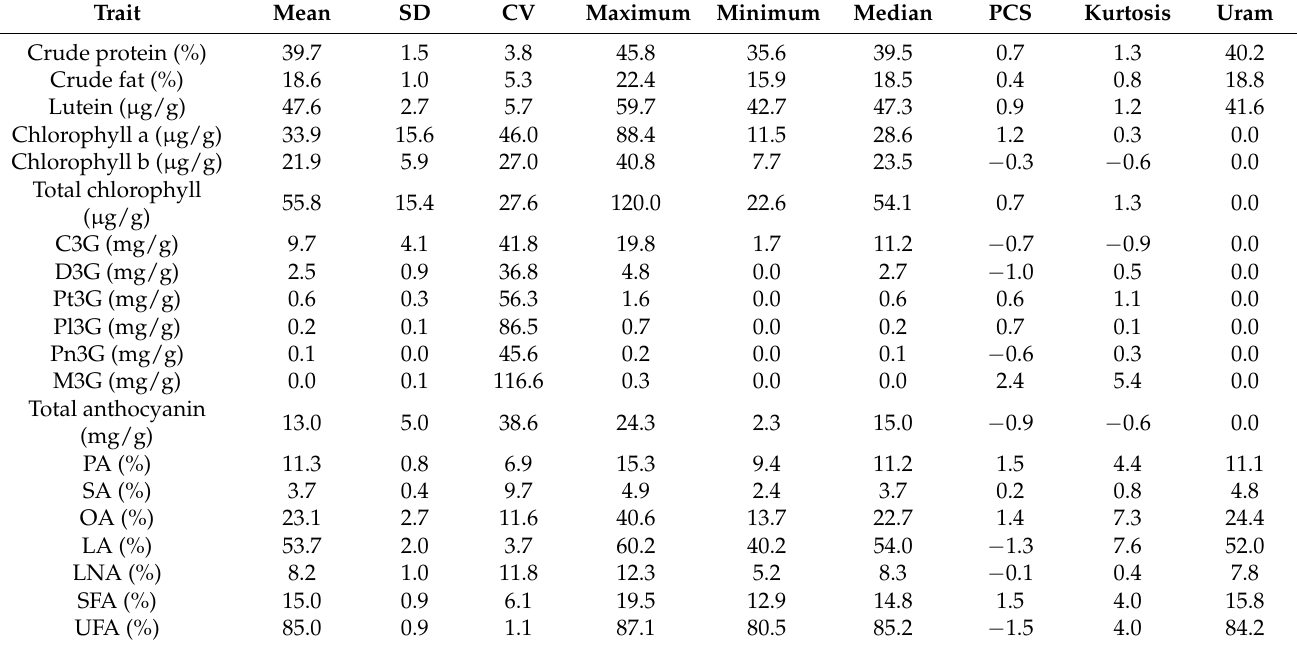
Table 1. Statistical data for seed composition traits of 469 black soybean germplasms with green cotyledons (including check cultivars ‘Cheongja 3’ and ‘Cheongja’), and a yellow soybean check cultivar, ‘Uram’, over three years